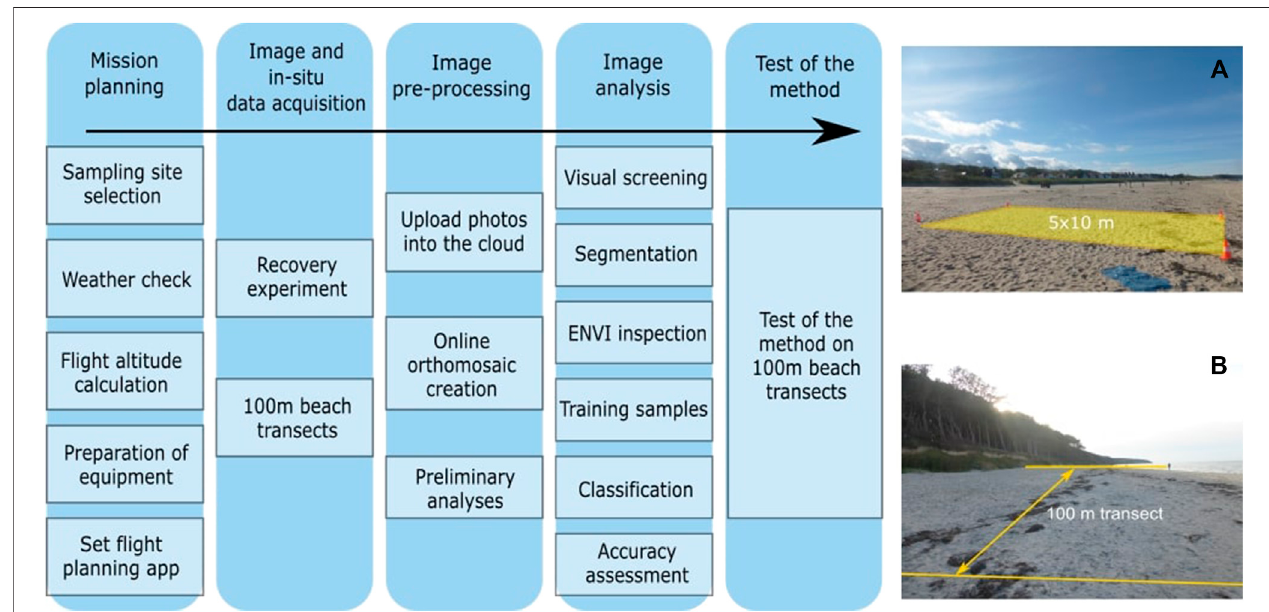
FIGURE 2 | (1) Work fl ow for drone-based monitoring and object-based supervised classi fi cation based on fi ve main steps, each with separate single steps to follow.(2)Setupforsamplingoftherecoveryexperiment (A) and100 mbeachtransects (B) .Intherecoveryexperiments,selecteditems(basedonmostcommonitems foundintheBalticregion)wereplacedinacleanedareaof5 × 10 m.The100 mmonitoringwasbasedonOSPARguidelines.Afterdronemappingofthezone,litterwas collected on the area from the intertidal to the back of the beach with two people and then counted and classi fi ed according to the OSPAR list of